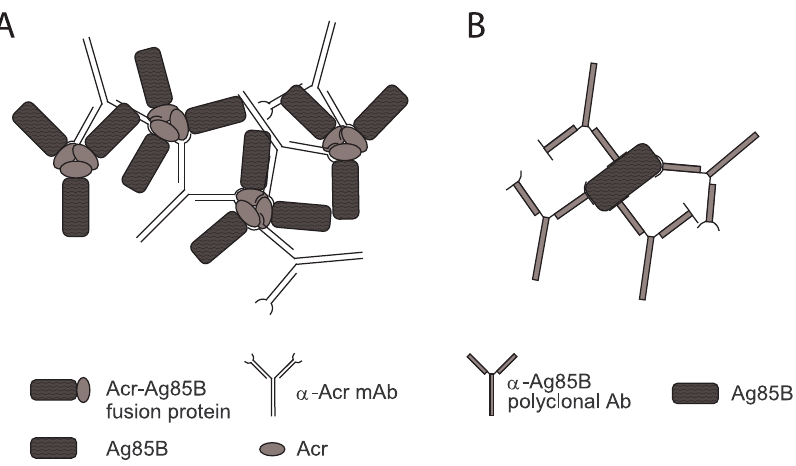
Figure 1. Schematic representation of immune complex mimics (ICM) based on Acr-Ag85B fusion protein and an anti-Acr mAb (A) and the classical immune complexes (IC) based on Ag85B antigen of MTB and polyclonal Abs (B). For ICM, the fusion protein is depicted as a trimer, which is one of the predominant molecular forms for Acr in solution. Each mAb molecule must bind to a different monomer unit of Acr (A); in contrast, polyclonal Abs can bind to the same Ag85B molecule (B).